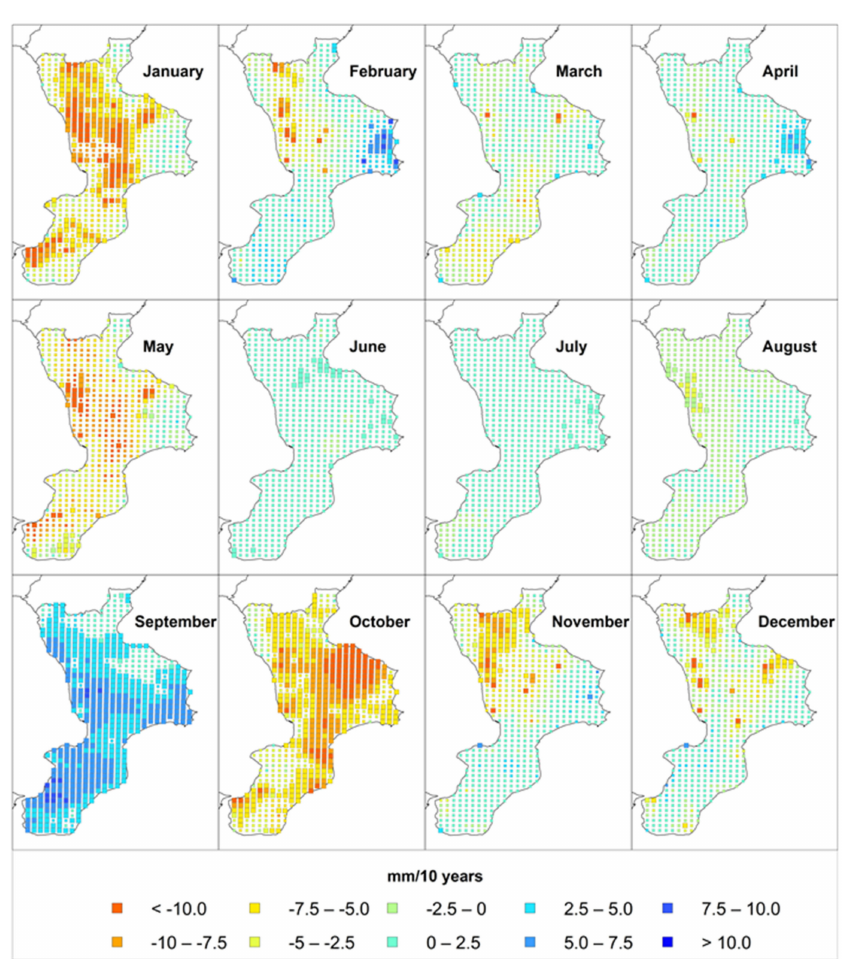
Figure 4. Monthly trend maps. Squares dimension indicates the significance level of the trend: large squares p < 0.05, small squares